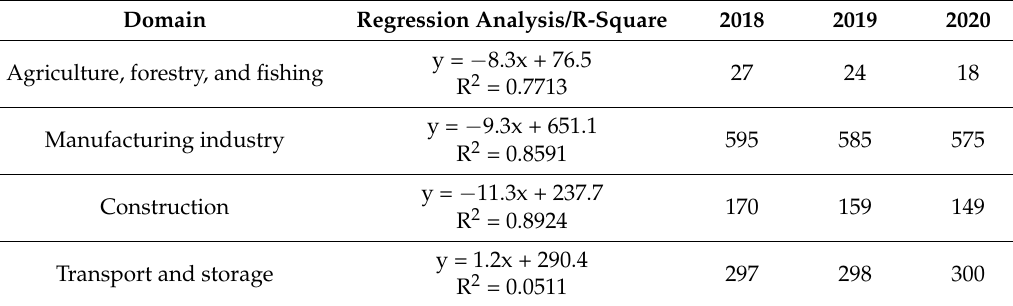
Table 9. Trends of accident at work for period 2018–2020 in